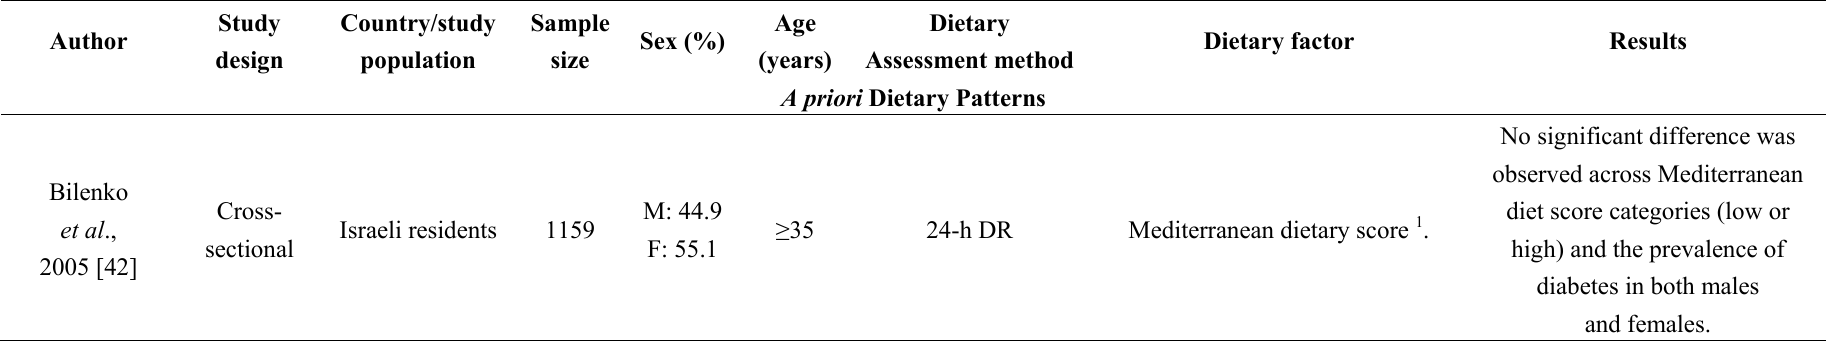
Table 2. Association between dietary patterns and